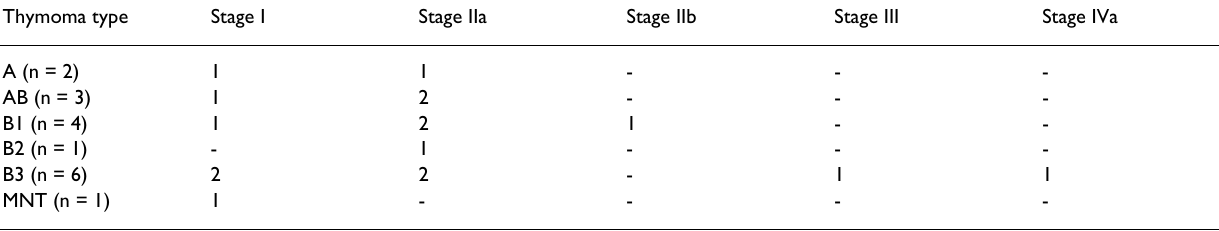
Table 2: Pathologic Diagnosis and Thymoma Pathologic Staging* Thymoma type